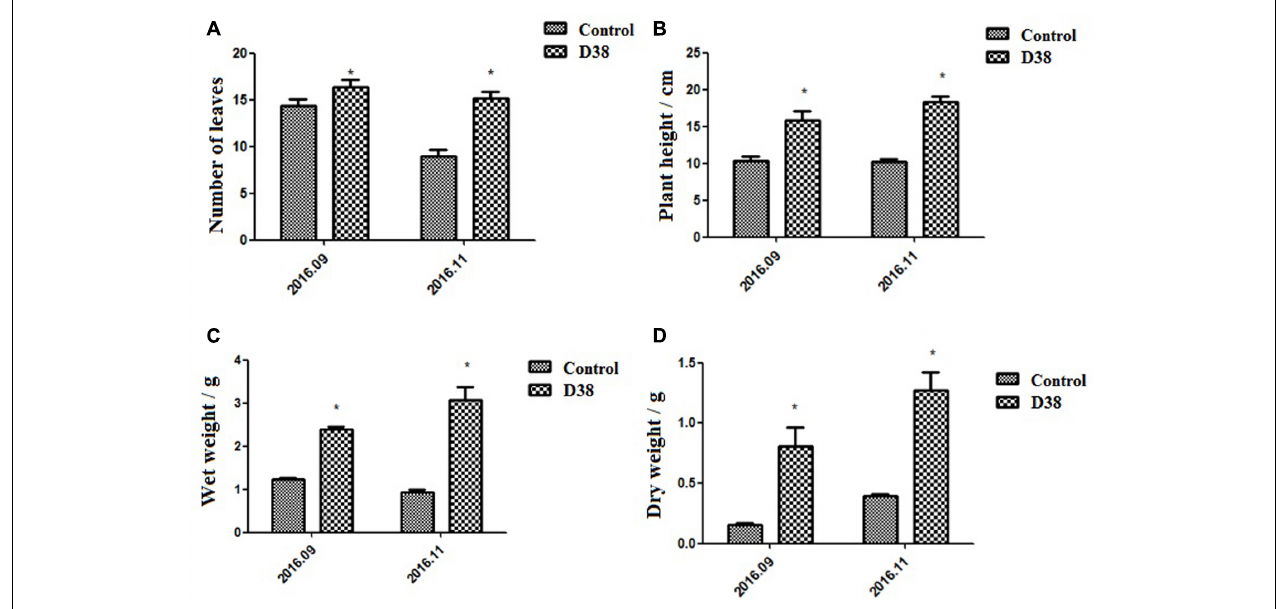
FIGURE 7 | Morphological indexes under the treatment of 20 g D38 fertilizer compared with untreated group from September 2016 to December 2016. (A) Number of leaves; (B) Plant height; (C) Wet weight; (D) Dry